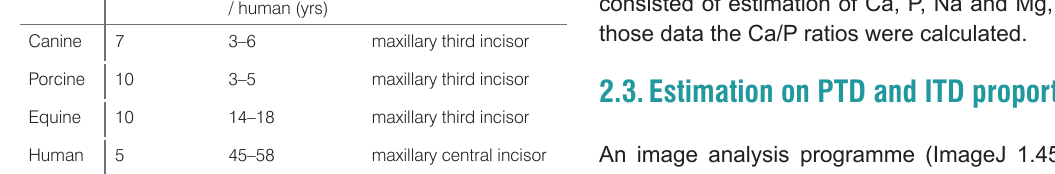
Table 2. Data on dentin samples included in the study Species No. of teeth